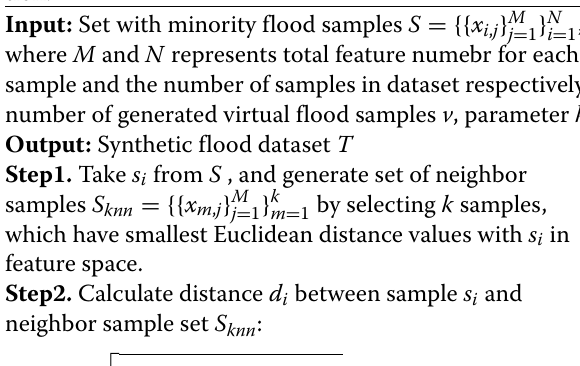
Algorithm 1 SMOTE method for flood data augmenta-